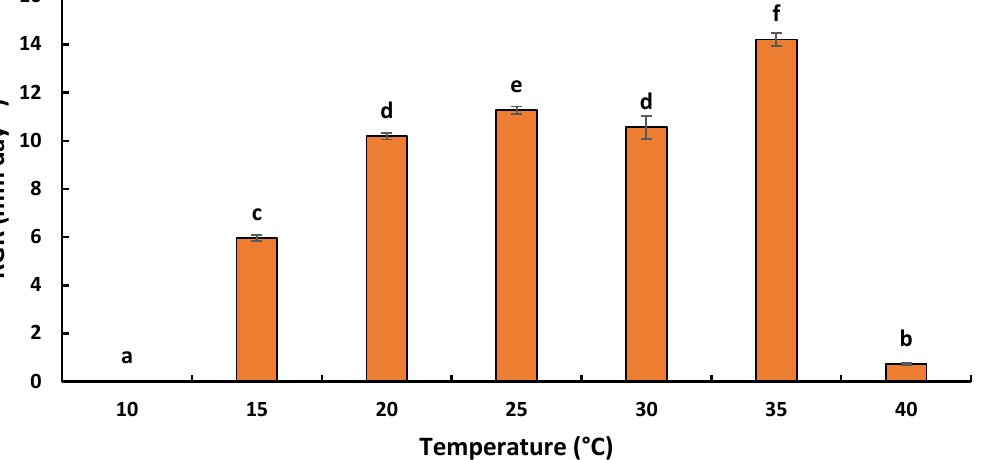
Figure 4. Radial growth rate (mm day − 1 ) versus temperature ( ◦ C) for L. viticola . Datasets are the mean of three replicates. Error bars represented standard deviations. Treatments with the same letter are not significantly different according to the Tukey test p ≤ 0.05.